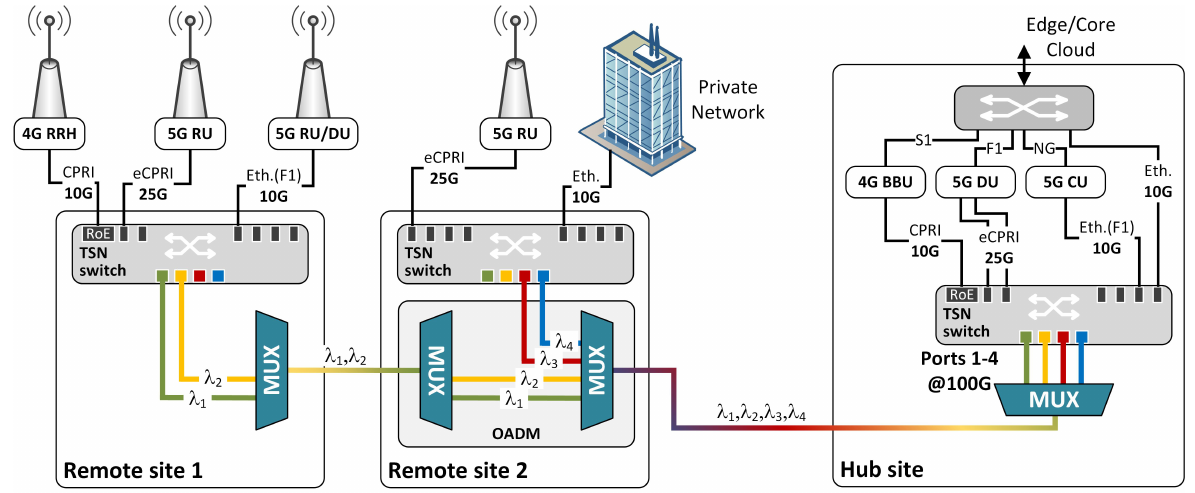
Figure 1. Example of packet-optical xHaul access network carrying 4G, 5G, and private network traffic between a hub and two remote sites (one transmission direction depicted in the optical